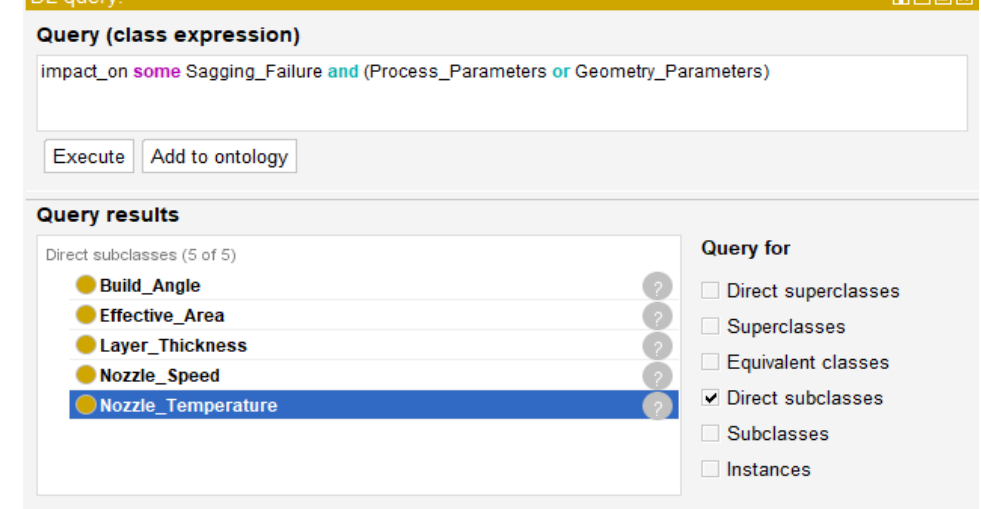
Figure 4. Schematic diagram for constructing AM ontology: ( a ) Implementation of “Impact on”; ( b ) Implementation of “Subclass of” in Protégé software.